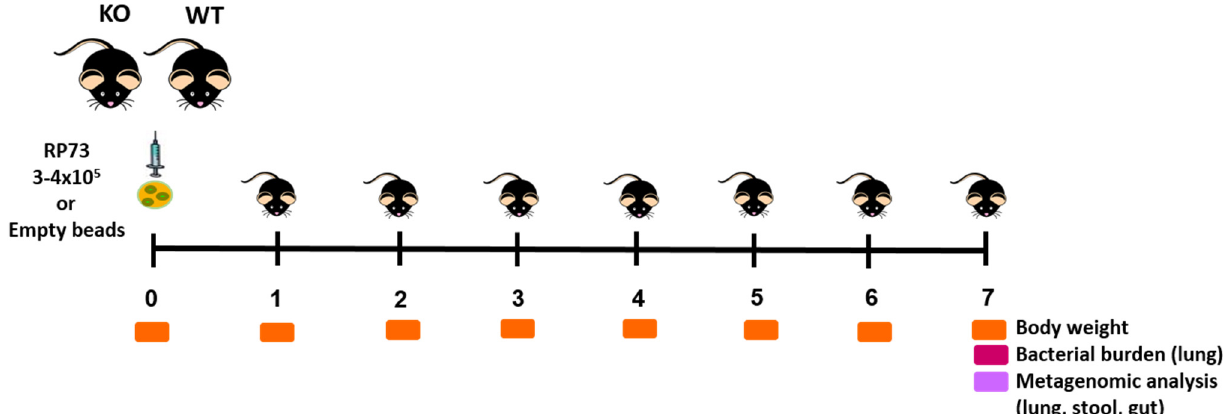
Figure 5. Experimental design. Mice were intratracheally infected with 3–4 × 10 5 of clinical strain P. aeruginosa RP73 embedded in agar beads or empty beads and were sacrificed after seven days. Lungs, stool, and the final straight portion of the rectum (mucosae + feces) were aseptically excised and processed for metagenomic analysis. Read-outs of the disease progression were body weight changes, health status and CFUs in the lung.